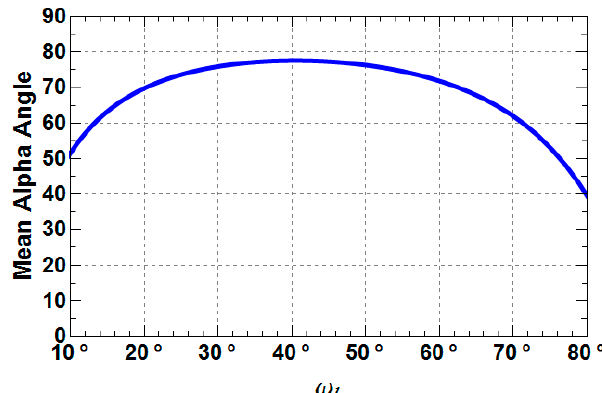
Figure 11. Sensitivity of polarimetric mean scattering alpha angle α with local incidence angle ω 1 Remote Sens. 2016 , 8 , 818 ( ε s = 20, ε t = 10, L SXD = 1, ϕ = 0°, θ 1 = 30°).